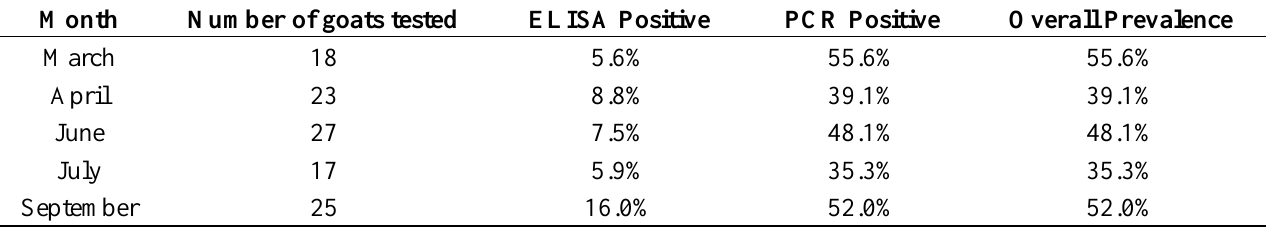
Table 3. Monthly evolution of the prevalence of goats positive to SRLV by ELISA and PCR. PCR results in right and left udder coincided.